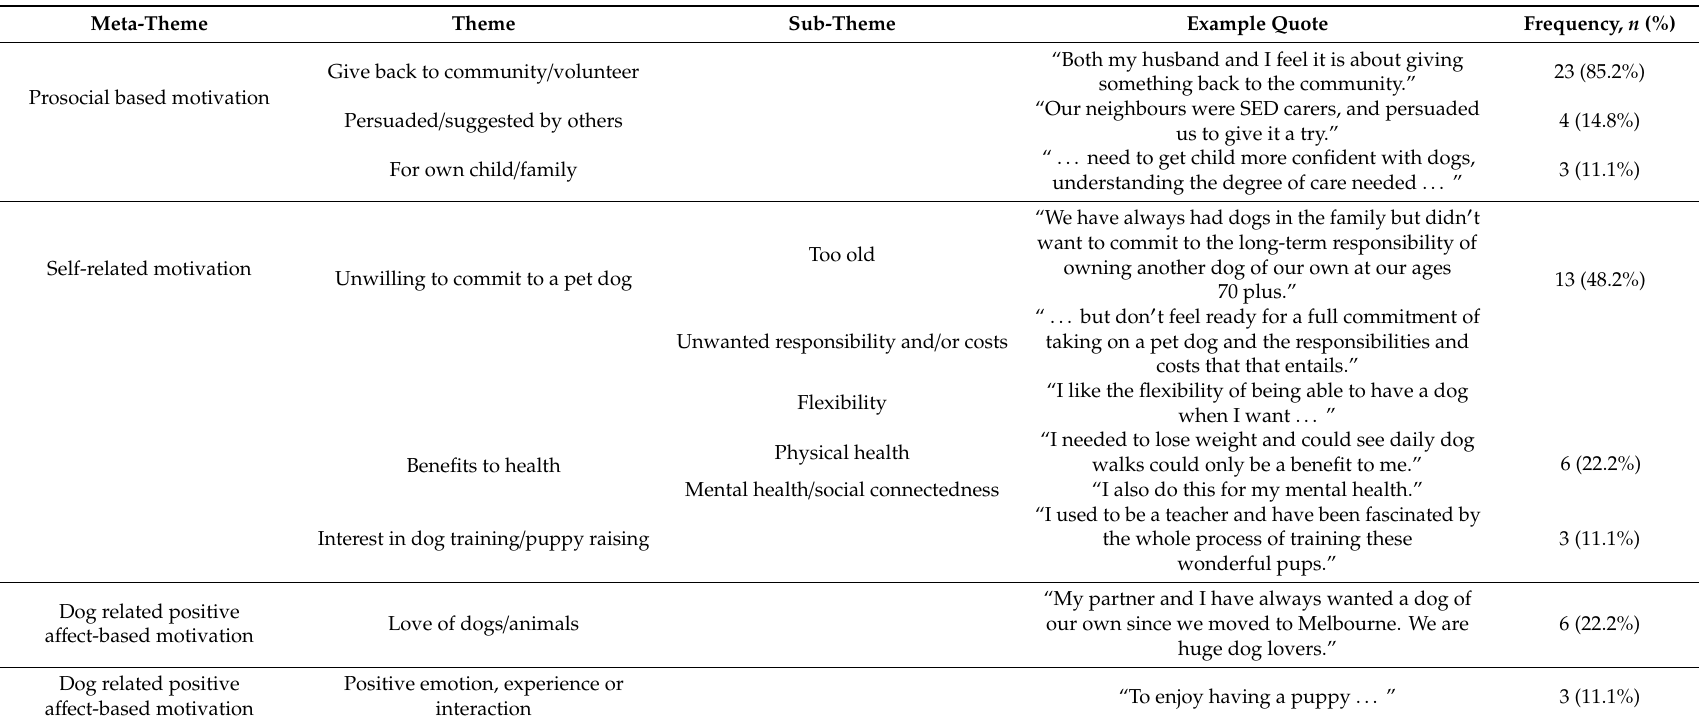
Table 8. SED motivations for becoming a SED carer ( n =